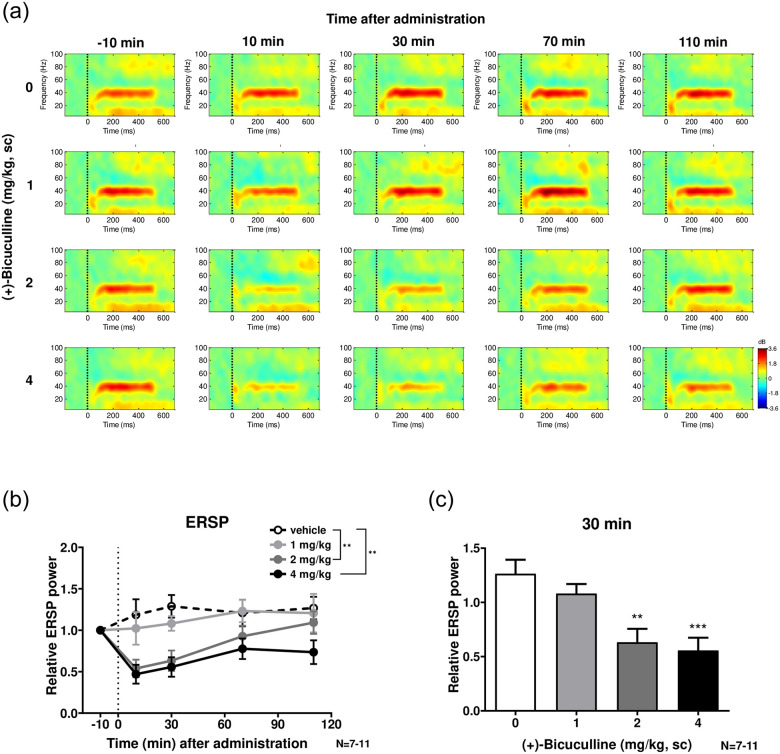
The effect of (+)-bicuculline on the 40 Hz ERSP.a, Heat map representation of mean time-frequency plots of ASSR at 40-Hz stimulation at −10 (baseline), 10, 30, 70 and 110 min following (+)-bicuculline (0, 1, 2 and 4 mg/kg, sc) treatment. b, Time-course of the 40 Hz ERSP following (+)-bicuculline treatment. c, Effect of bicuculline on the 40 Hz ERSP at 30 min after treatment. Bicuculline significantly (4 mg/kg) and dose-dependently decreased ERSP. Values are mean ± SEM. The number of rats was 12 in each group.